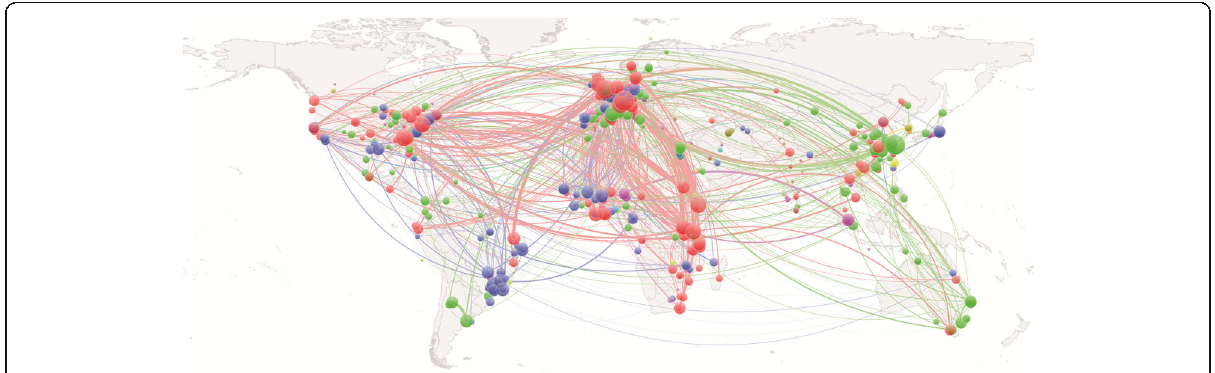
Fig. 6 Map of current schistosomiasis research collaborations. Geographical patterns of collaboration based on co-authored publications on schistosomiasis in 2016. Made with Natural Earth (free vector and raster map data at naturalearthdata.com). The colors indicate clusters as assigned by the VOSviewer. Nodes within a cluster have stronger coupling with other nodes in the same cluster than with nodes in other